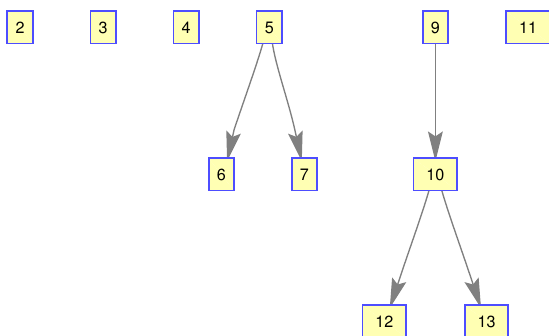
Figure 7. The structure of subgroup targets during k > 70.